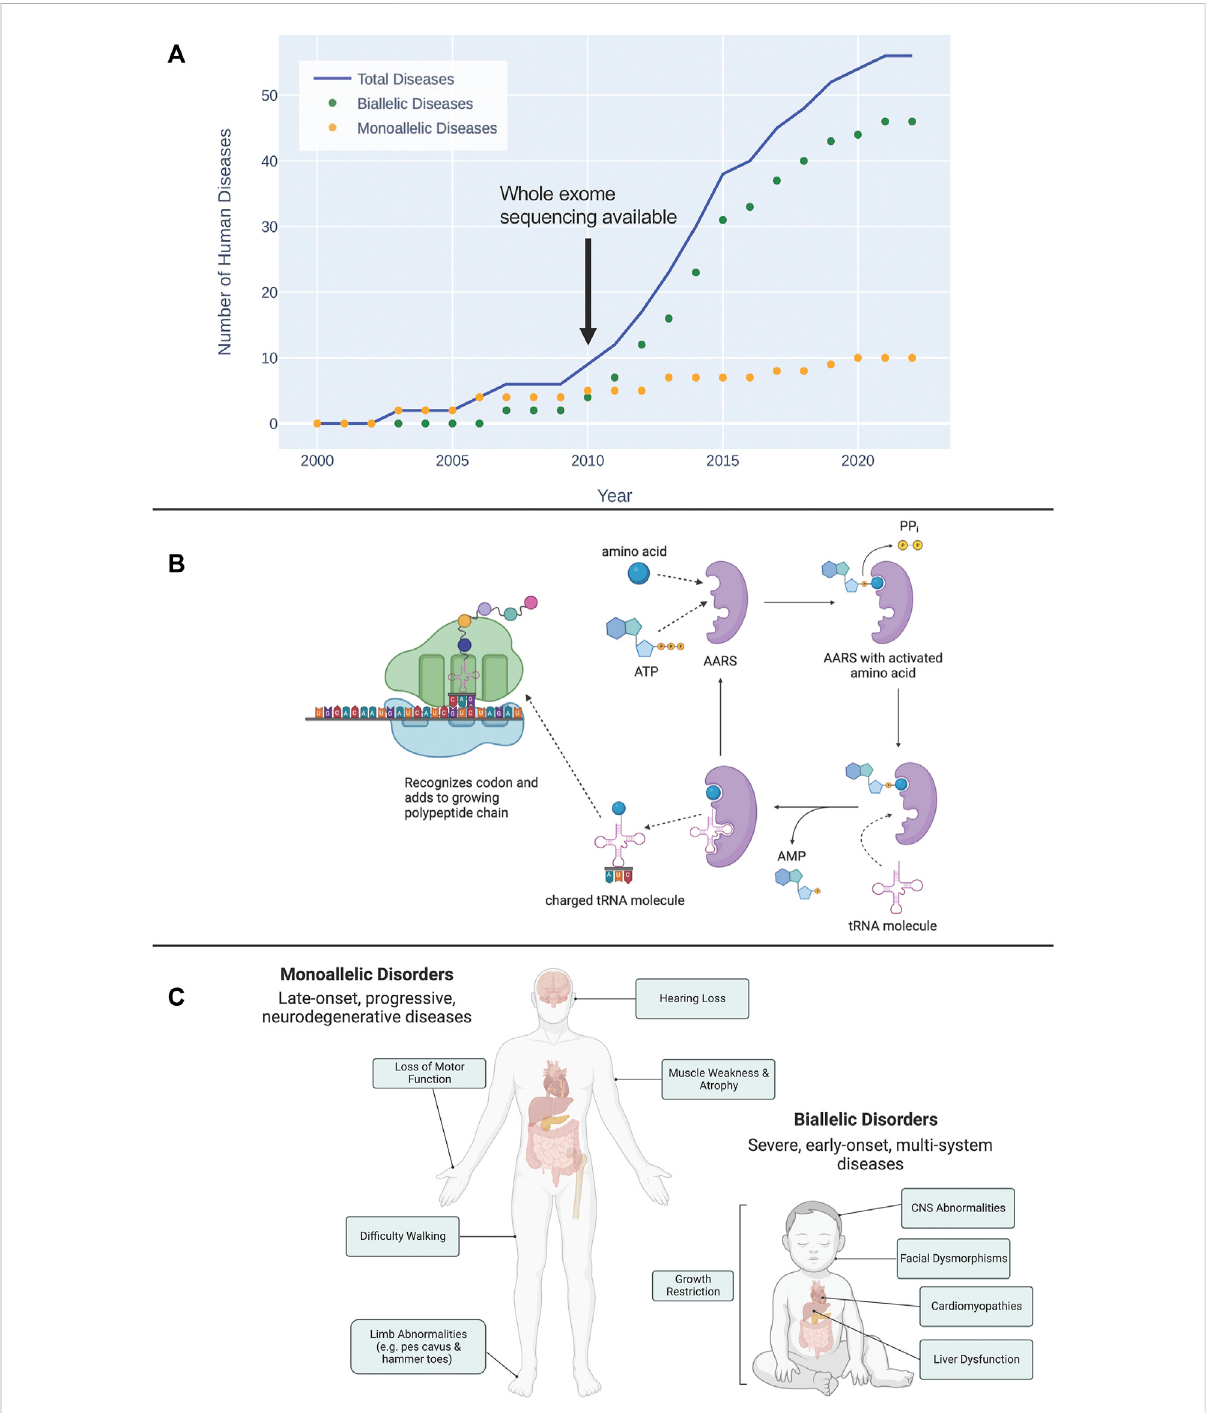
FIGURE 1 (A) The timeline of discovery of biallelic and monoallelic human diseases caused by damaging aaRS variants since 2000. (B) Overview of the esteri fi cation reaction, catalyzed by aaRS proteins, that charges a tRNA molecule with its cognate amino acid. This charged tRNA then travels to a translating ribosome where it recognizes a codon and adds its amino acid to the growing polypeptide chain. (C) General characterization of symptoms associated with diseases caused by monoallelic and biallelic pathogenic aaRS variants. Diseases caused by monoallelic variants are typically late-onset, progressive, neurodegenerative disorders. Damaging biallelic variants cause severe, early-onset, multi-system